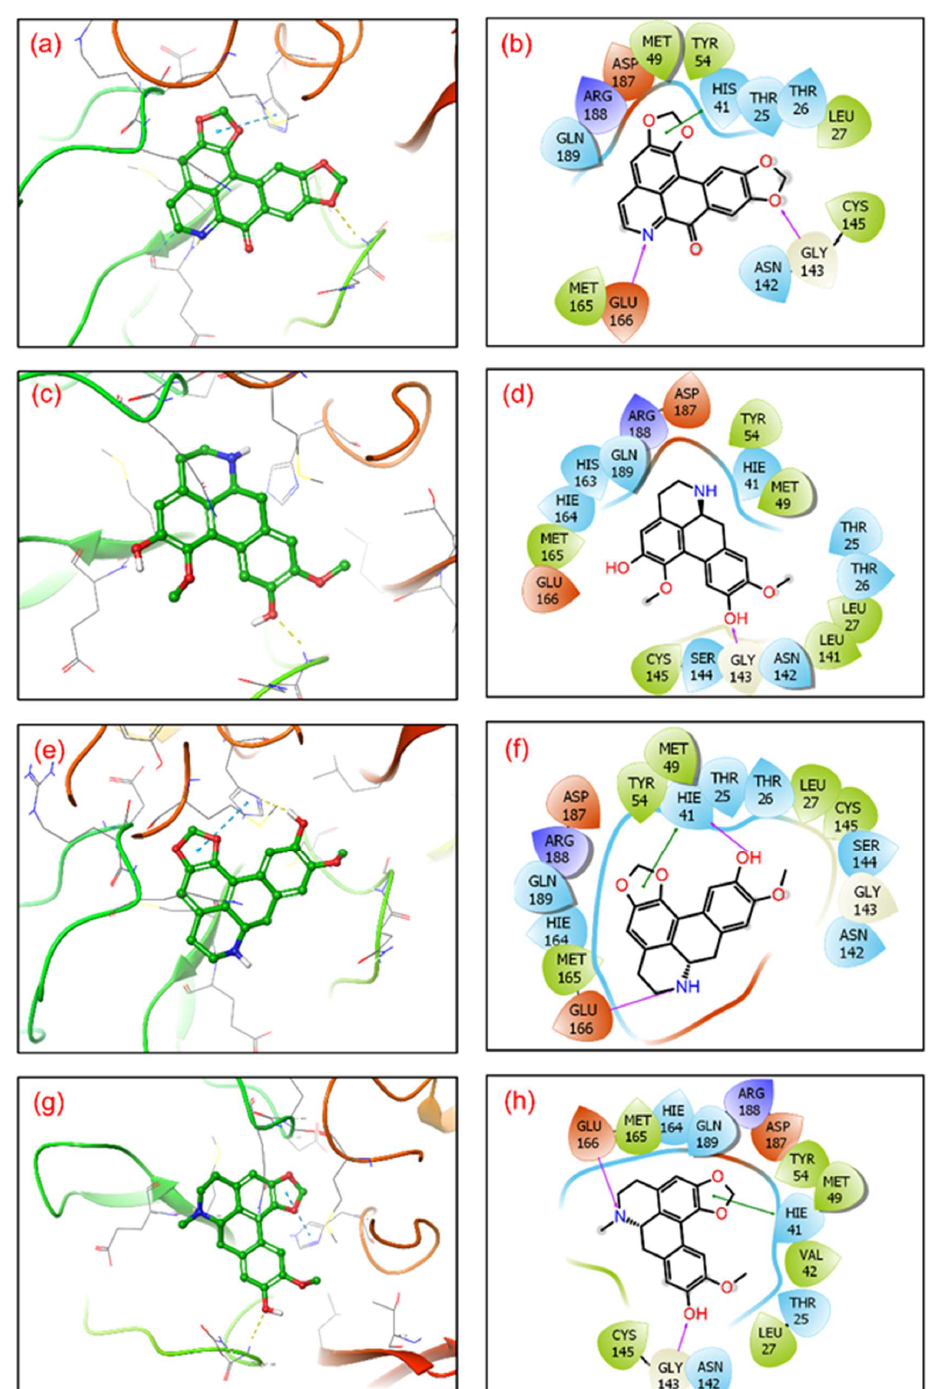
Figure 2 . 3D representation of SARS-CoV-2 docked complexes exhibiting intermolecular interac- tions with potential compounds; ( a , b ) Cassameridine, ( c , d ) Laetanine, ( e , f ) Litseferine, and ( g , h ) Cassythicine. Docked complexes with the active residues of the viral protease have been shown in a 2D interaction diagram as hydrogen bond formation (pink arrows), π-π interactions (green lines), hydrophobic (green), polar (blue), red (negative), violet (positive), and glycine (grey) interactions. Additionally, hydrophobic, polar, positive and negative charge interactions with binding site residues were recorded in the SARS-CoV-2 M pro -phytochemical compound complex (Figure 2, Table 2). The re-docking and intermolecular interaction analysis of